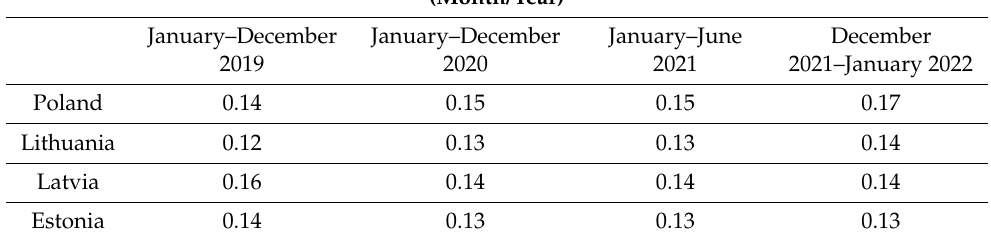
Table 1. Average electricity prices per kilowatt-hour from January 2019 to early January 2022 in Poland and the Baltic States [52].